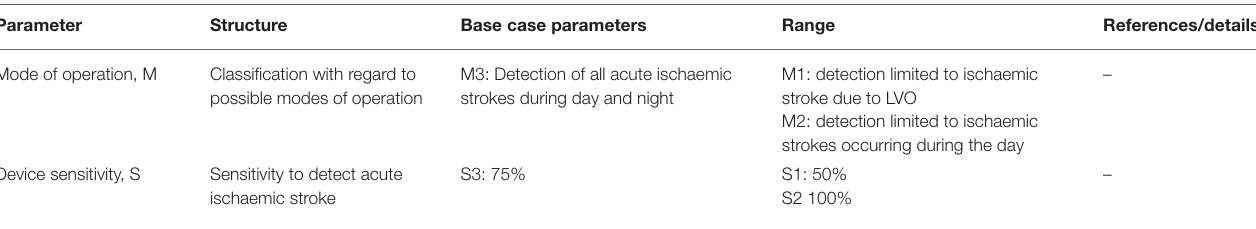
TABLE 4 | Device related parameters used in the